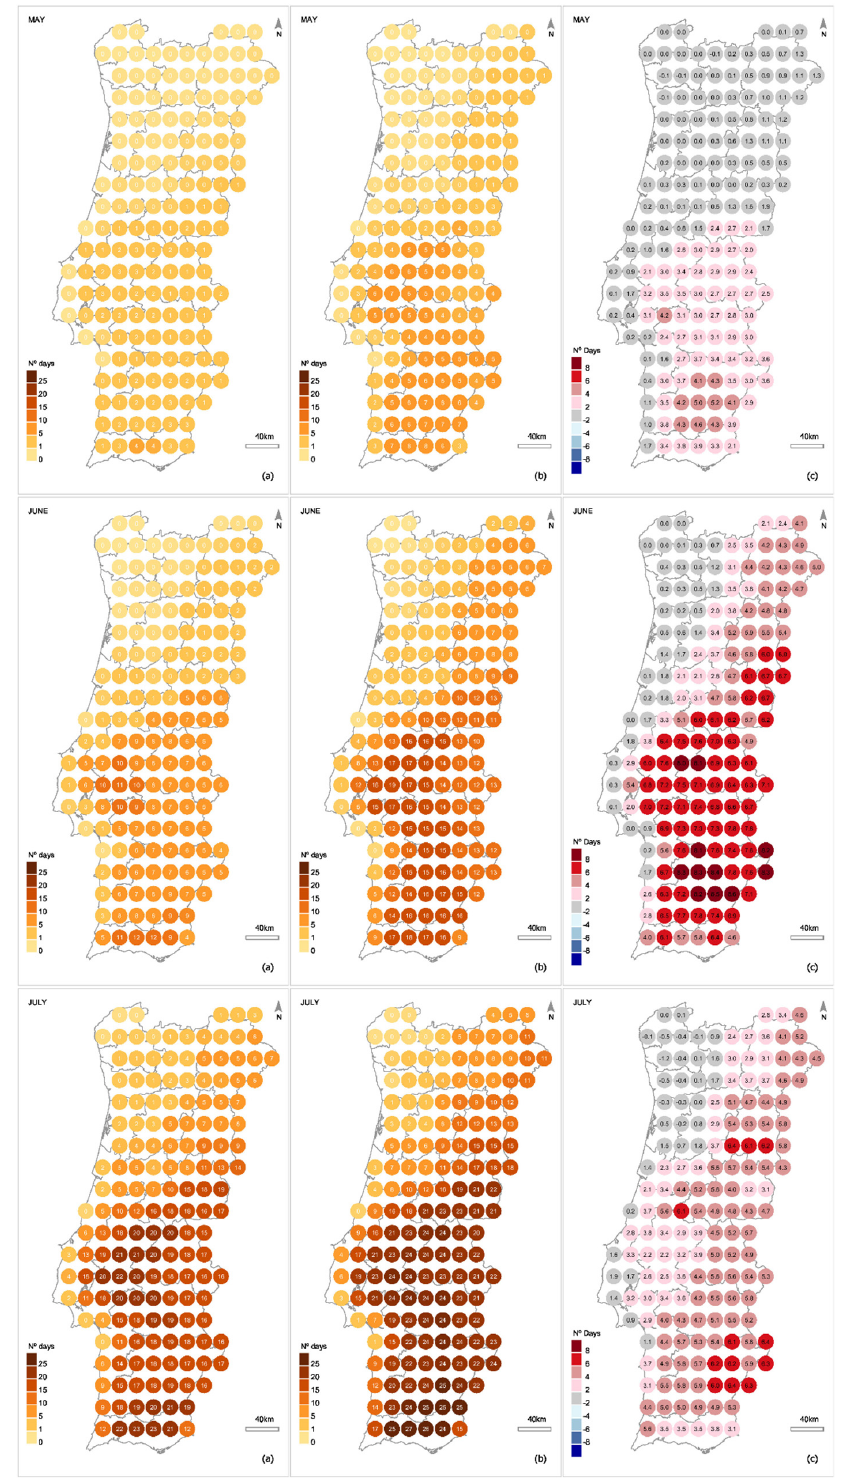
Figure 9. Average number of days per month with FWI above 38.3 by grid point (ERA5 0.25° × 0.25°). From top to bottom: May, June and July. Left-hand charts ( a ) represent the 1980–1999 period, middle charts ( b ) represent the 2000–2018 period, and right-hand charts ( c ) represent the point-by-point arithmetic difference ( b )-( a ).